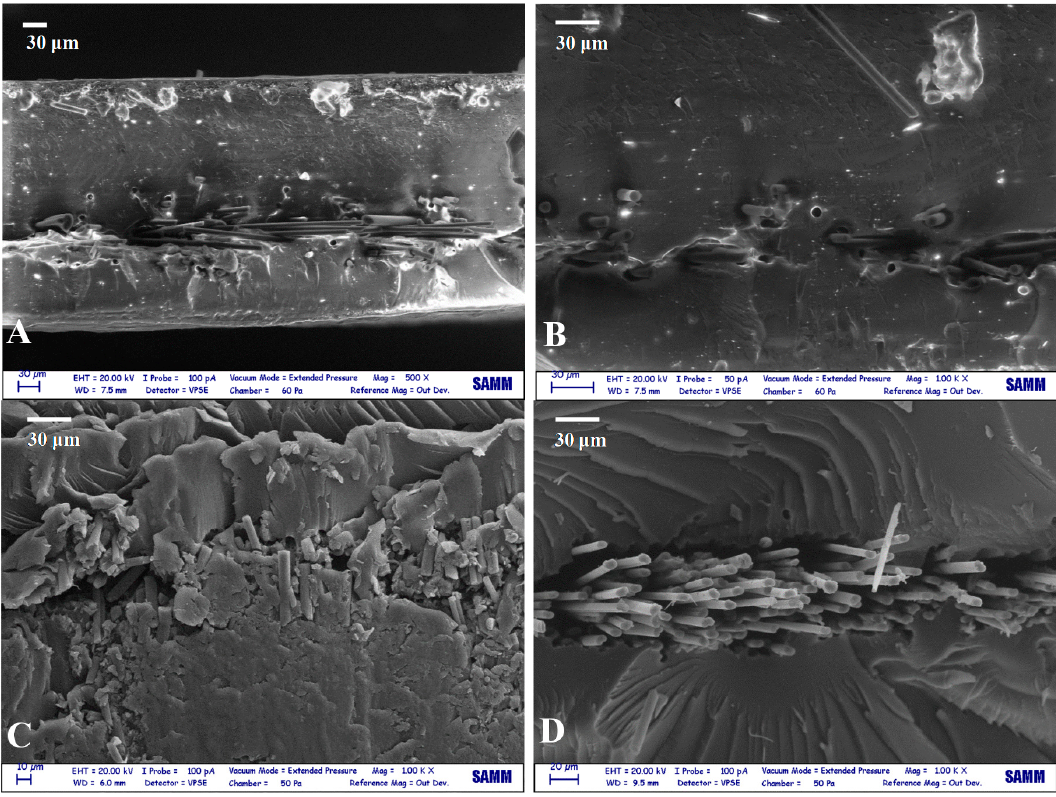
Figure 4. Cross-sectional SEM micrographs of fractured surfaces of DA polymer composites with ( A,B ) nonwoven carbon mat and ( C,D ) unidirectional carbon